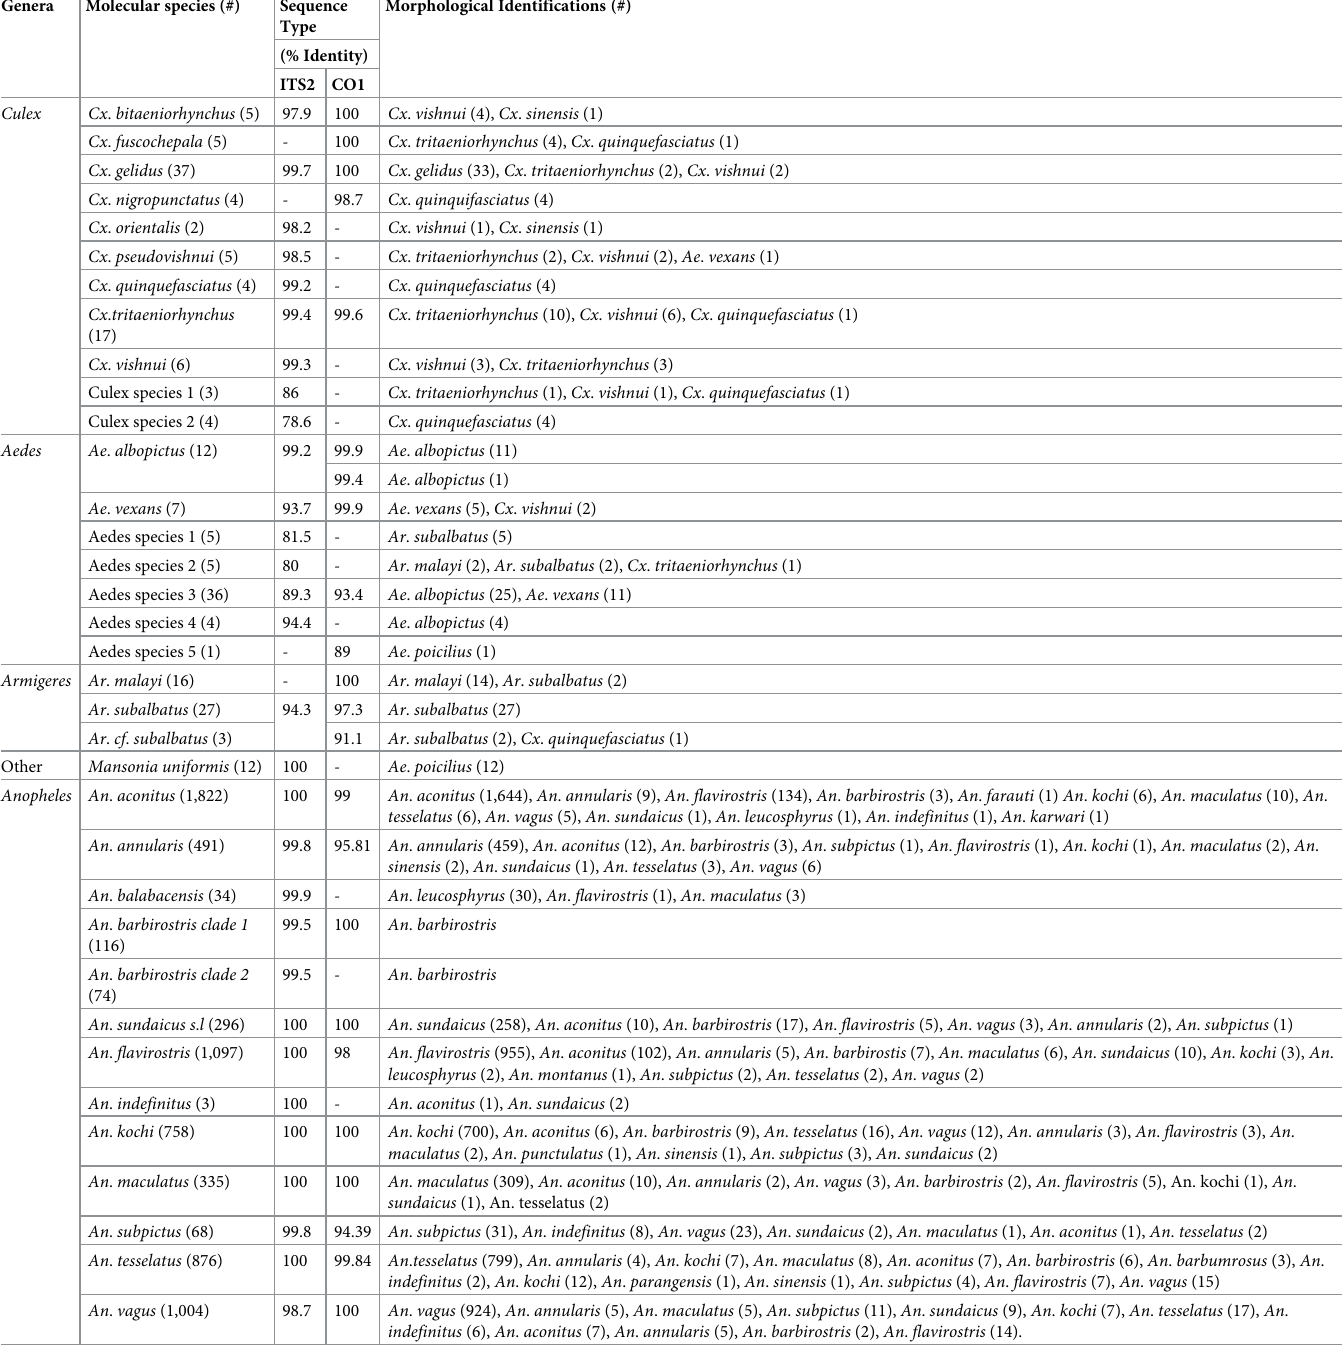
Table 1. Species identifications. Molecular species identifications (with the number of specimens) are listed with ITS2 and CO1 similarities to sequences in the databases (NCBI and BOLD). Morphological identifications of the molecularly identified specimens are also listed. Genera Molecular species